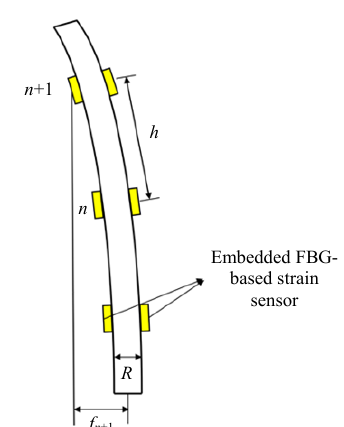
Fig. 2 Schematic of the working principle of embedded FBG-based strain sensing on the PVC